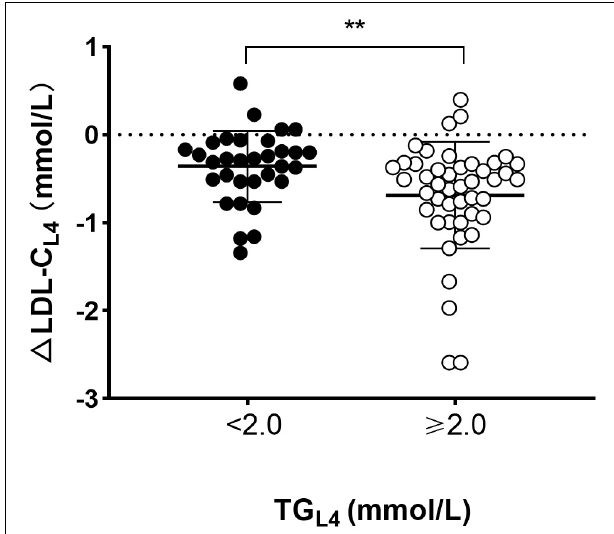
FIGURE 3 | Comparison of absolute reduction in LDL-C level between patients with and without high TG at 4 h after lunch. Absolute changes in LDL-C level ( (cid:49) LDL-CL 4 ) and TG level ( (cid:49) TGL 4 ) at 4 h after lunch. Solid circles represented patients with high TG (TG ≥ 2.0 mmol/L) and open circles represented those without high TG (TG < 2.0 mmol/L) at 4 h after lunch. Cholesterol: 1 mmol/L = 38.7 mg/dL. TG: 1 mmol/L = 88.6 mg/dL. ** p < 0.01 when compared to each